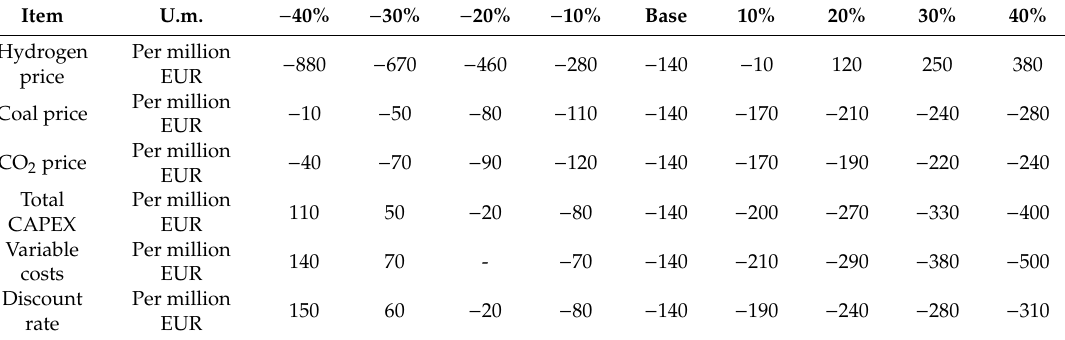
Table 9. Sensitivity analysis for hard coal gasification w/o CCS (HC_H2_0).